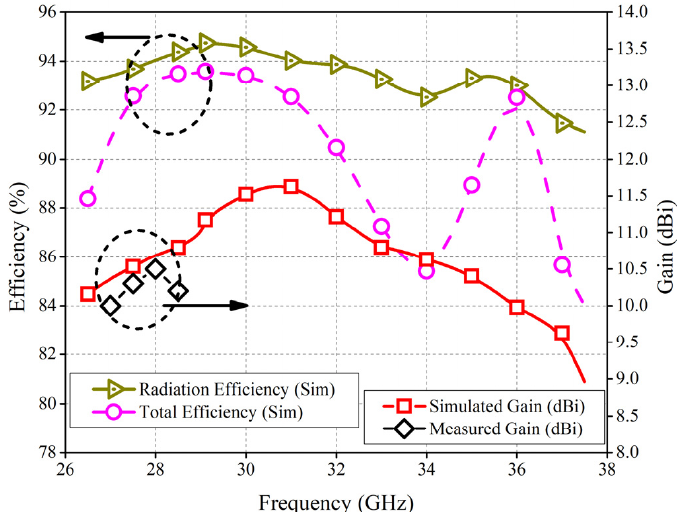
Figure 7. Performance parameters of array systems.